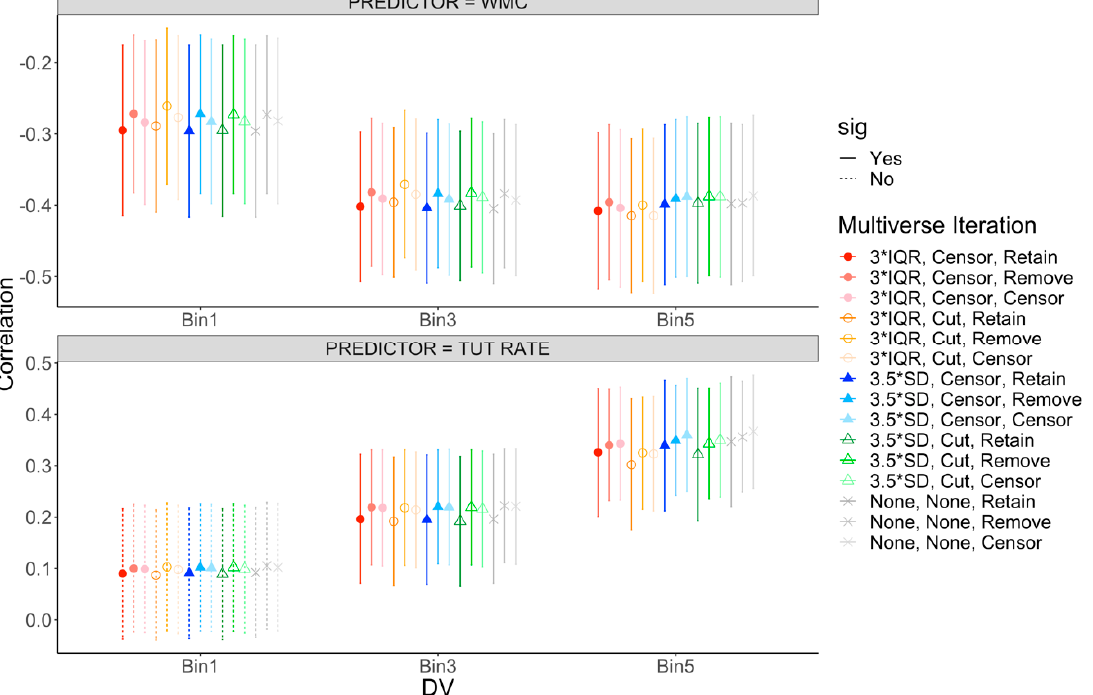
Figure 4. Mini-multiverse of ranked-bin correlations. The top panel presents correlations with working memory capacity (WMC). The bottom panel presents correlations with rate of task-unrelated thought (TUT). Points reflect the correlation, with error bars representing the 95% confidence interval (CI) around the estimate. Circles represent iterations where outlying trials were defined by interquartile ranges (IQR), triangles represent iterations where outlying trials were defined by standard deviations (SDs), and xs represent iterations where no criteria were applied to outlying trials. Filled shapes reflect iterations where outlying trials were censored to the respective cuto ff value before aggregating and open shapes reflect iterations where outlying trials were removed before aggregating. Colors presented in this figure match those illustrating the multiverse iterations in Figure 3. Solid CIs represent significant correlations, and dashed CIs represent non-significant correlations at p =